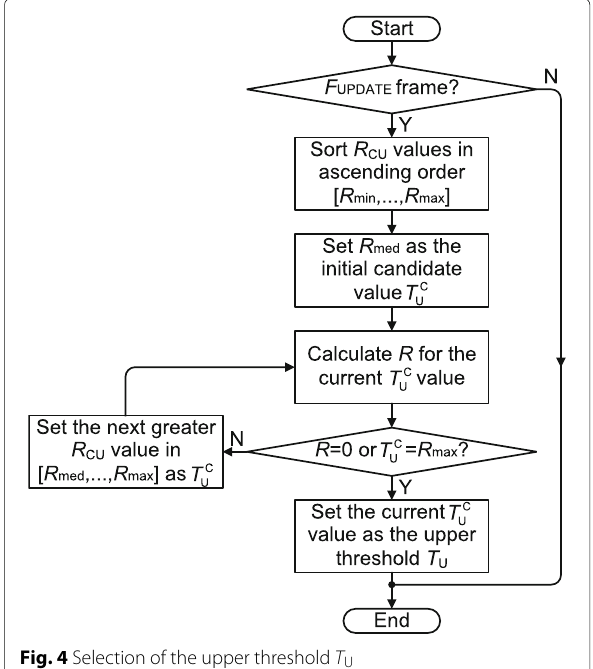
Fig. 4 Selection of the upper threshold T